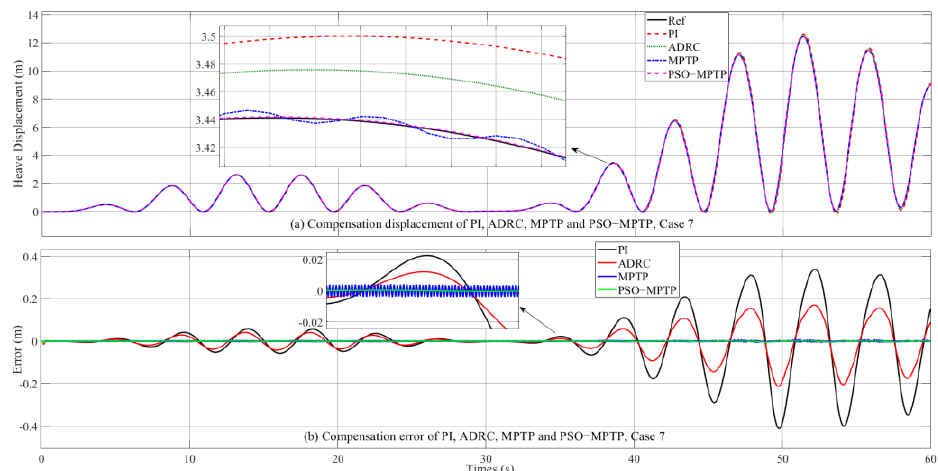
Figure 16. ( a ) Compensation displacement of PI, ADRC, MPTP, and PSO − MPTP, Case 7. ( b ) Com- pensation error of PI, ADRC, MPTP, and PSO − MPTP, Case 7. pensation error of PI, ADRC, MPTP, and PSO − MPTP, Case 7.